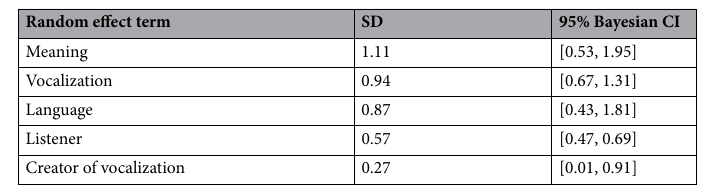
Table 2. Random effects standard deviations from the Bayesian logistic regression model for the field data; ordered from highest to lowest standard deviation; larger SDs indicate that accuracy levels varied more for that random effect